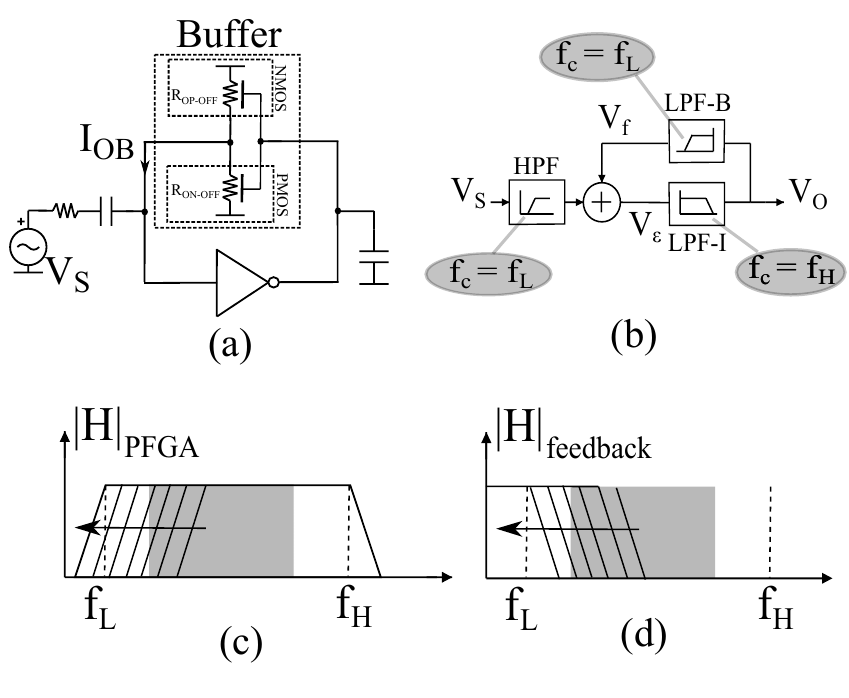
Figure 13. Large signal models for PFGA. ( a ) General large signal model. ( b ) Block Diagram of the PFGA. ( c ) Pass Band filter behaviour of the PFGA. ( d ) Low pass filter behaviour of the feedback.